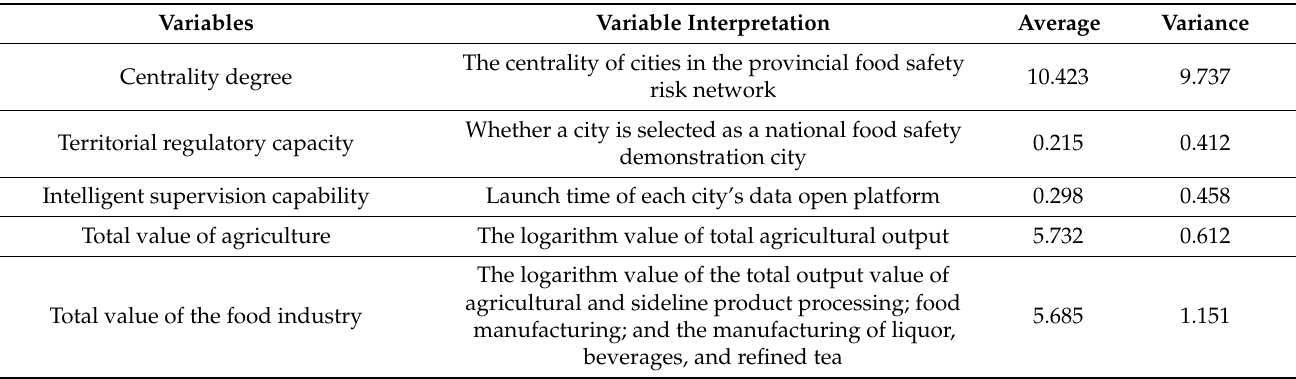
Table 8. Variables and descriptive